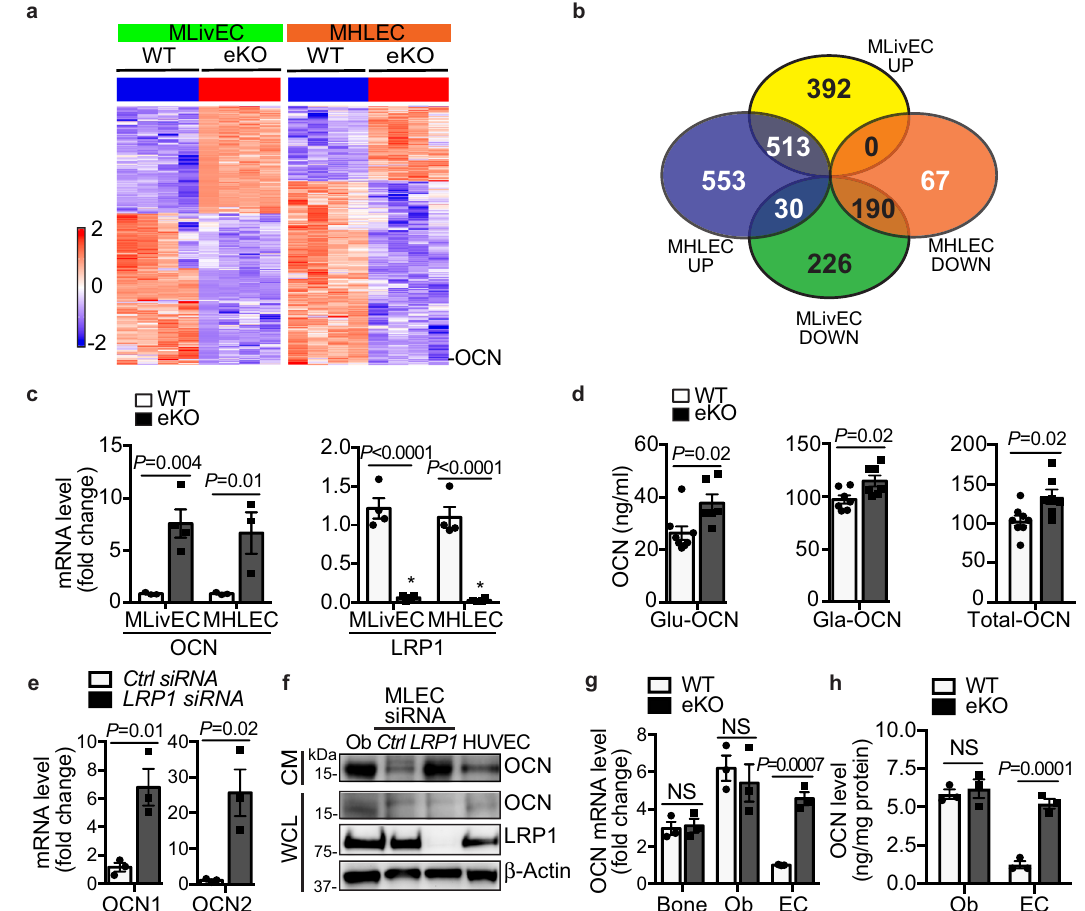
Fig. 1 Osteocalcin is induced in LRP1-depleted ECs. a Heatmaps of mRNA-seq data demonstrate changes in gene expression pro fi les of liver ECs (MLivECs) and heart and lung ECs (MHLECs) isolated from LRP1 (eKO, LRP1 f/f ; Cdh5-CreER + /- ) or their littermate control (WT, LRP1 f/f ; Cdh5-CreER -/- ) mice. b A Venn diagram shows upregulated (UP) or downregulated (DOWN) gene numbers in LRP1-depleted MLivECs and MHLECs. c Expression changes of OCN and LRP1 were con fi rmed by real-time PCR. d Blood levels of Glu-, Gla- and total-OCN. e OCN1 and OCN2 mRNA levels in mouse lung ECs (MLECs) following transfection of LRP1 or control siRNAs. f OCN levels in conditioned media (CM) and whole-cell lysates (WCL) of osteoblasts (Ob) and different ECs. HUVEC, human umbilical vein endothelial cell. g OCN mRNA levels in marrow- fl ushed bone, osteoblasts (Ob) and ECs isolated from wildtype (WT) or LRP1 eKO mice. h OCN levels in CM of Obs and ECs isolated from WT or LRP1 eKO mice. n = 3 ( c WT; c eKO, MHLEC), 4 ( c